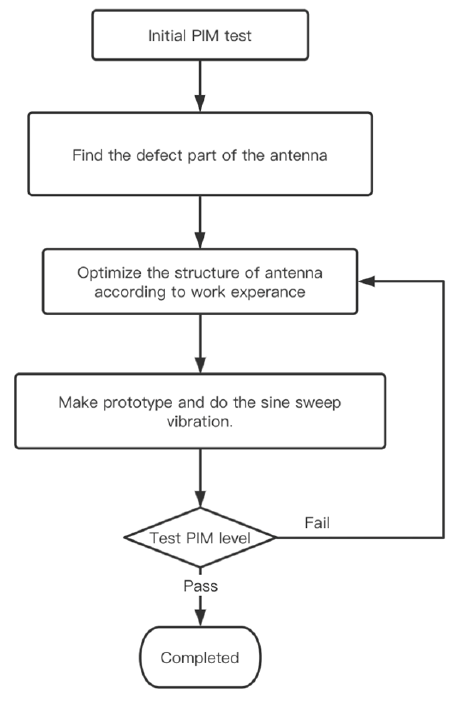
Figure 1. Traditional workflow of PIM improvement.